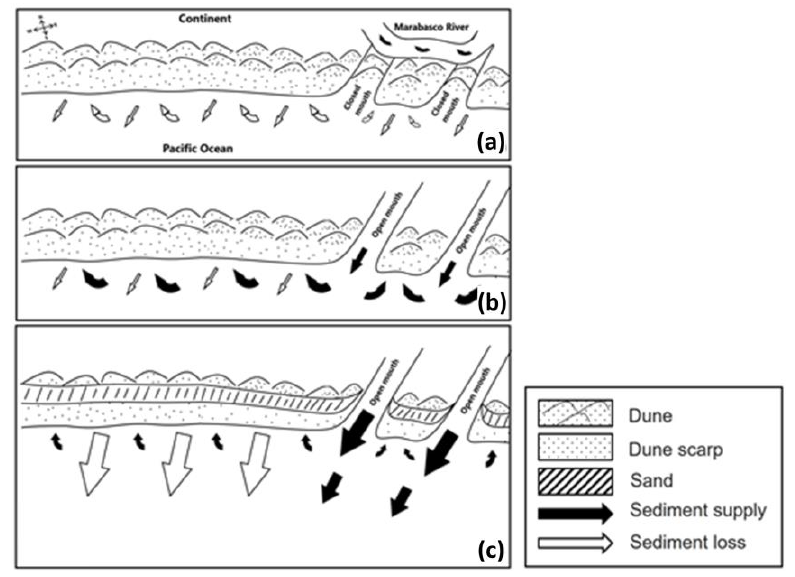
Figure 8. Playa del Coco: schematic morphodynamic functioning model. ( a ) Low energy, ( b ) medium energy, and ( c ) high energy. In all cases, the size of the arrow denotes the intensity of the event.